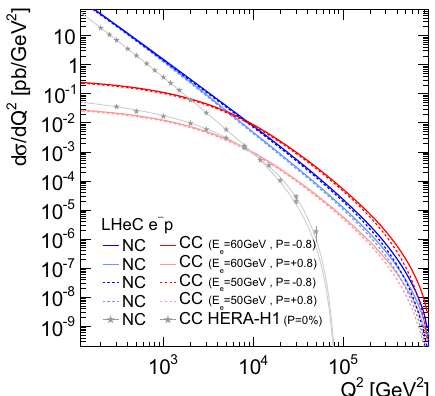
Fig. 2 Single differential inclusive DIS cross sections for polarized e − p NC and CC DIS at the LHeC for two different electron beam energies ( E e = 50 and 60 GeV). Cross sections for longitudinal elec- tron beam polarizations of P e = − 0 . 8 and + 0 . 8 are displayed. For comparison also data measured by H1 at HERA [23] at center-of-mass √ s = 920 GeV with unpolarized ( P = 0) electron beams energies of are